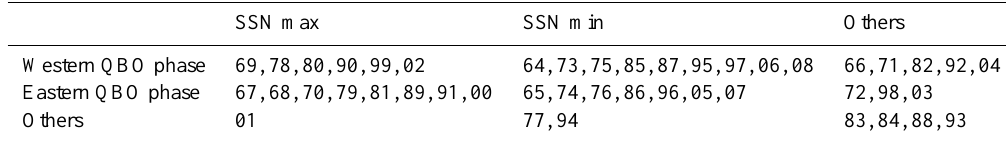
Table 4. Classification of years when SSN max or SSN min and/or western or eastern QBO